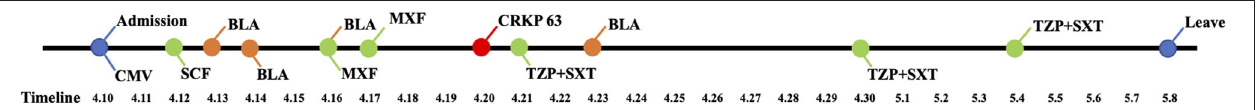
FIGURE 1 | The main process of the patient during hospitalization. CMV, mechanical ventilation; BLA, bronchoalveolar lavage; SCF, cefoperazone/sulbactam; MXF, moxifloxacin; TZP, piperacillin tazobactam; SXT, sulfamethoxazole.